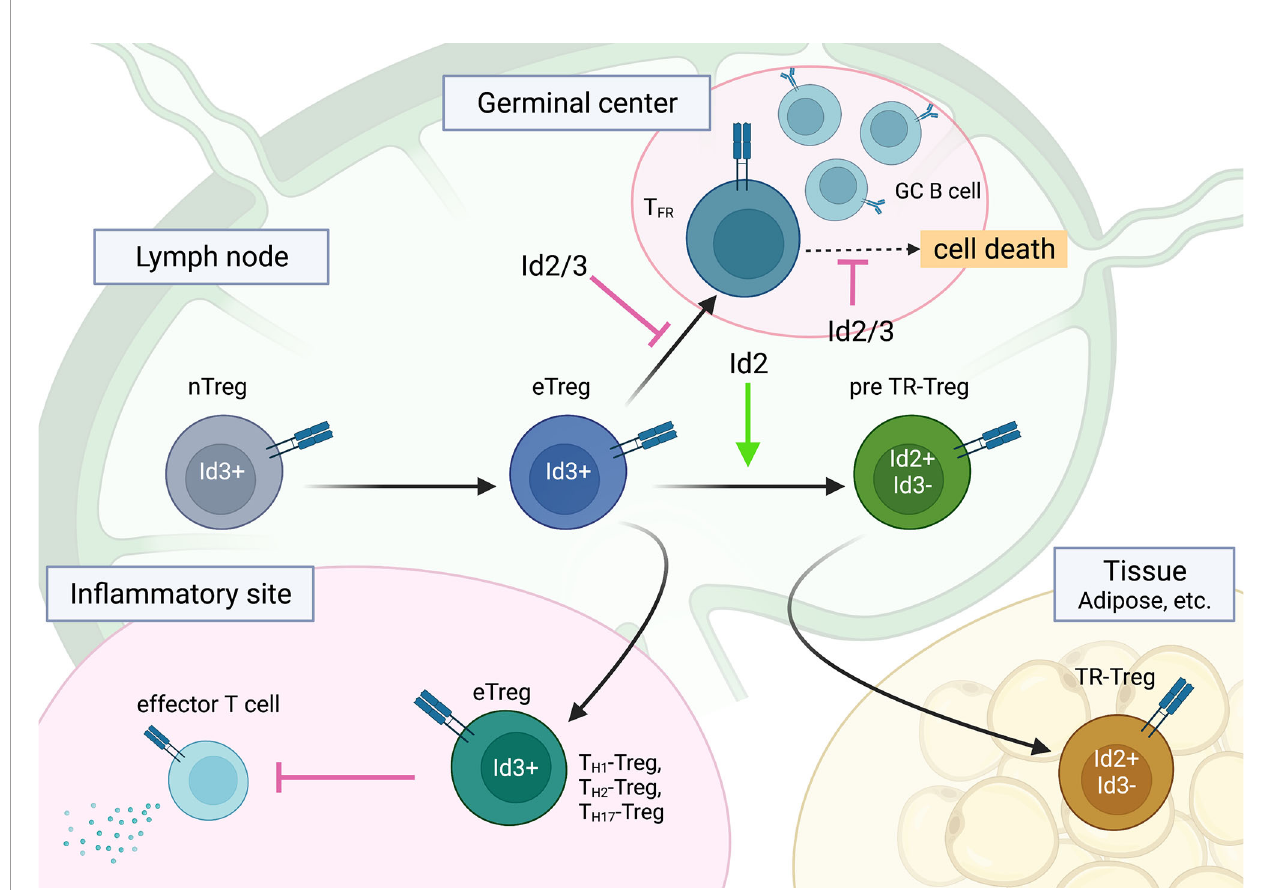
FIGURE 3 | The roles of Id2 and Id3 in Treg cell differentiation into subsets of effector Treg cells. Id2 and Id3 enforce the naïve state of Treg cells, especially in T FR cells. A regulatory switch of Id3 to Id2 plays a role in TR-Treg cell differentiation and function. This fi gure was created with